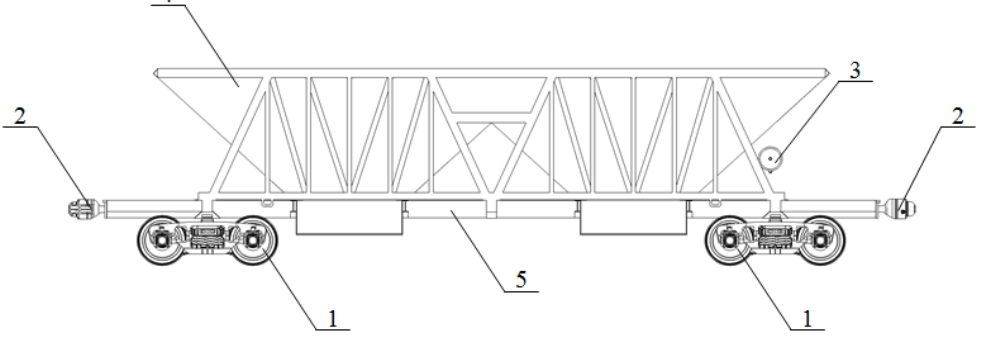
Figure 1. Two-section hopper wagon: 1 — module of the running gear; 2 — automatic coupling module; 3 — brake equipment module; 4 — body module; 5 — frame module.